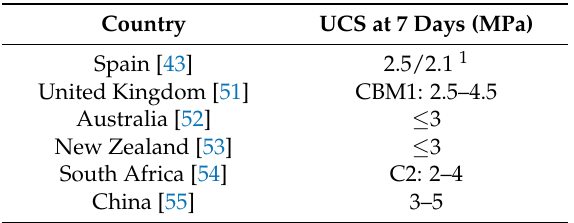
Table 2. Requirements specified in various countries for the unconfined compressive strength (UCS) of soil-cement.